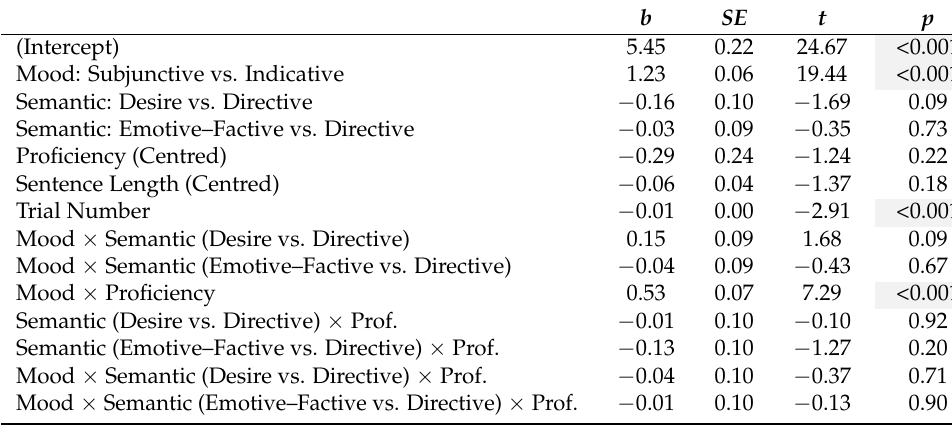
Mood × Semantic (Desire vs. Directive) Mood × Semantic (Emotive–Factive vs. Directive) Table A4. Estimates from the mixed-effect model for L2 judgment data.